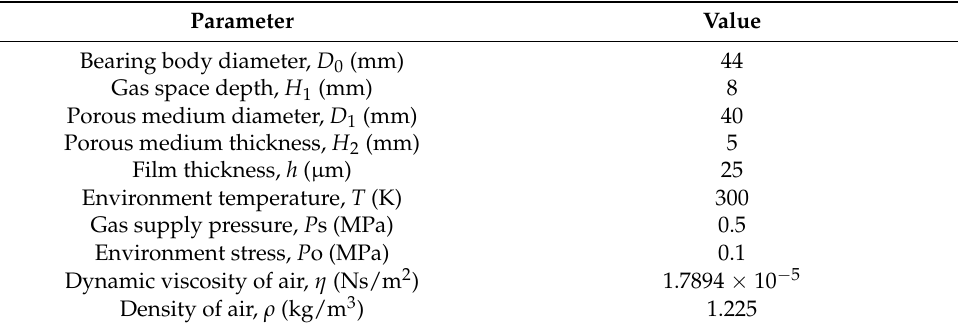
Table 1. Parameters of the air bearing.